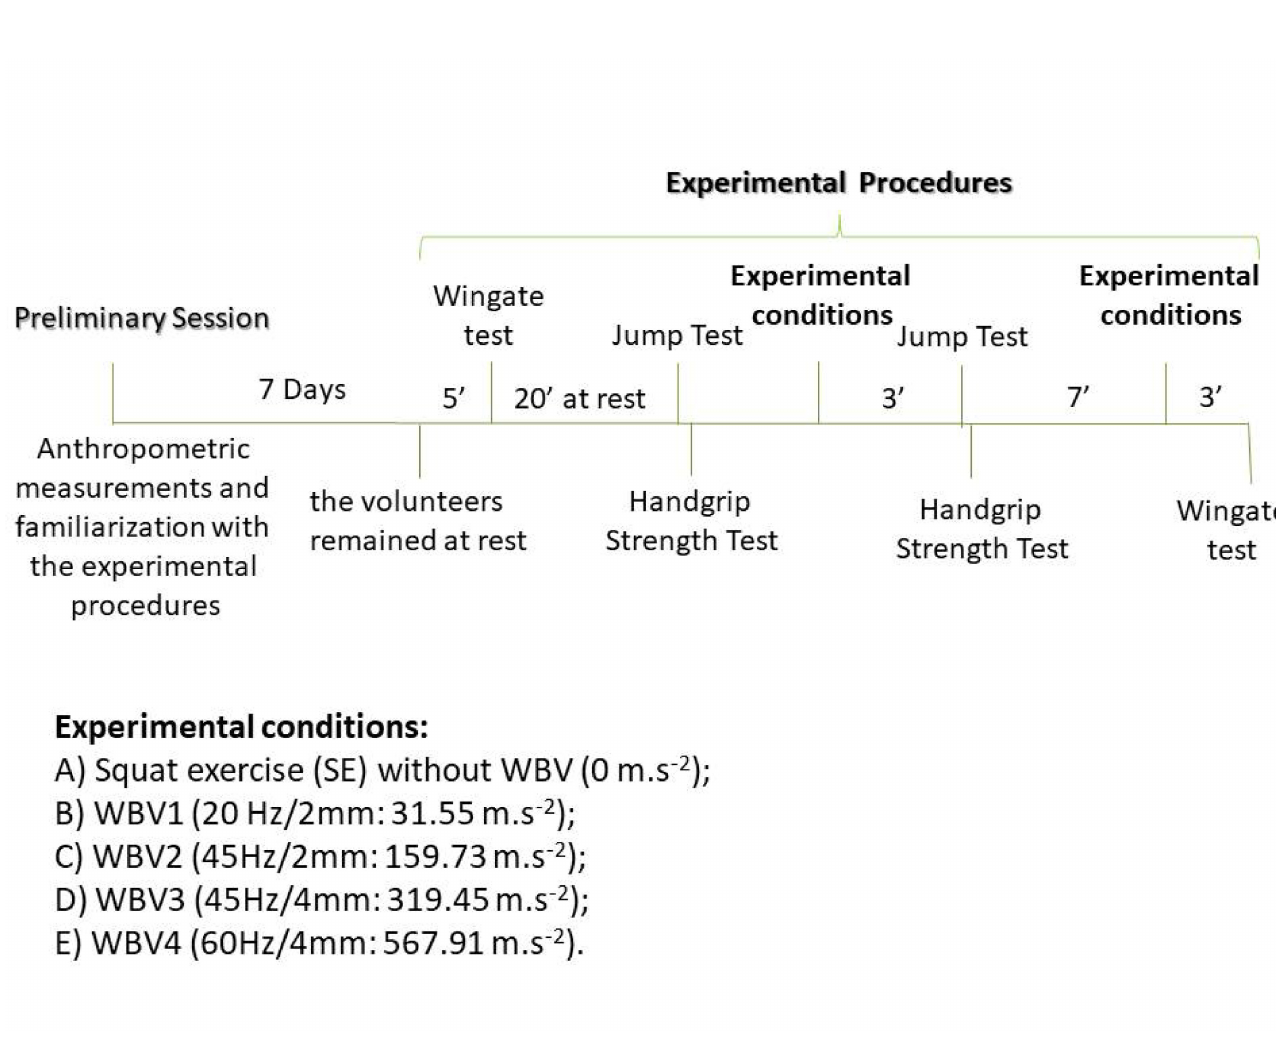
Figure 1 - Study flow